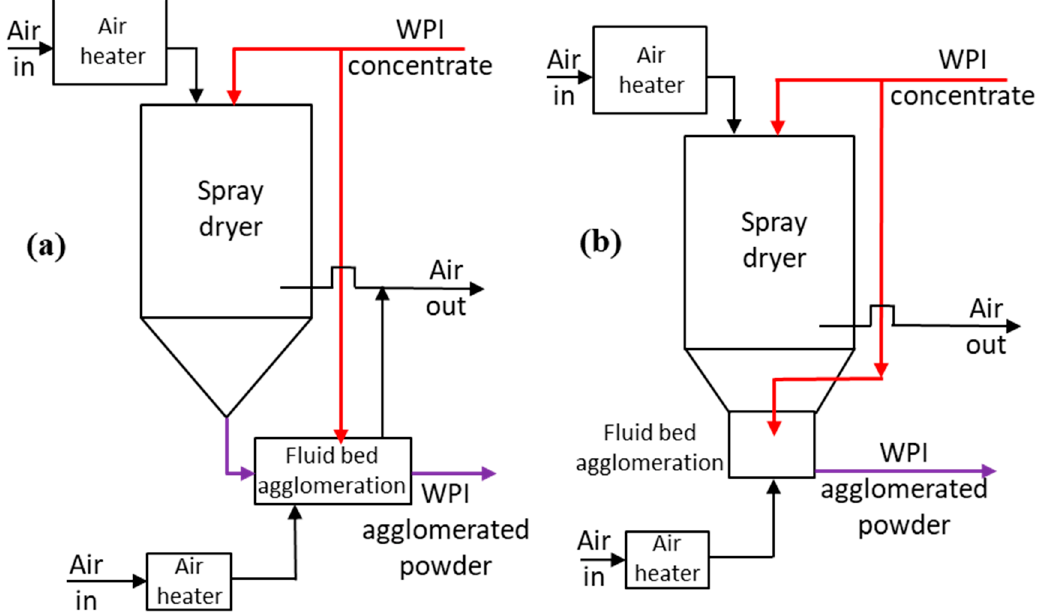
Figure 1. Schematic diagram of the application of self-agglomeration in the production of whey protein isolate (WPI) agglomerated powder ( a ) agglomeration in external fluid bed, ( b ) agglomeration in integrated fluid bed.